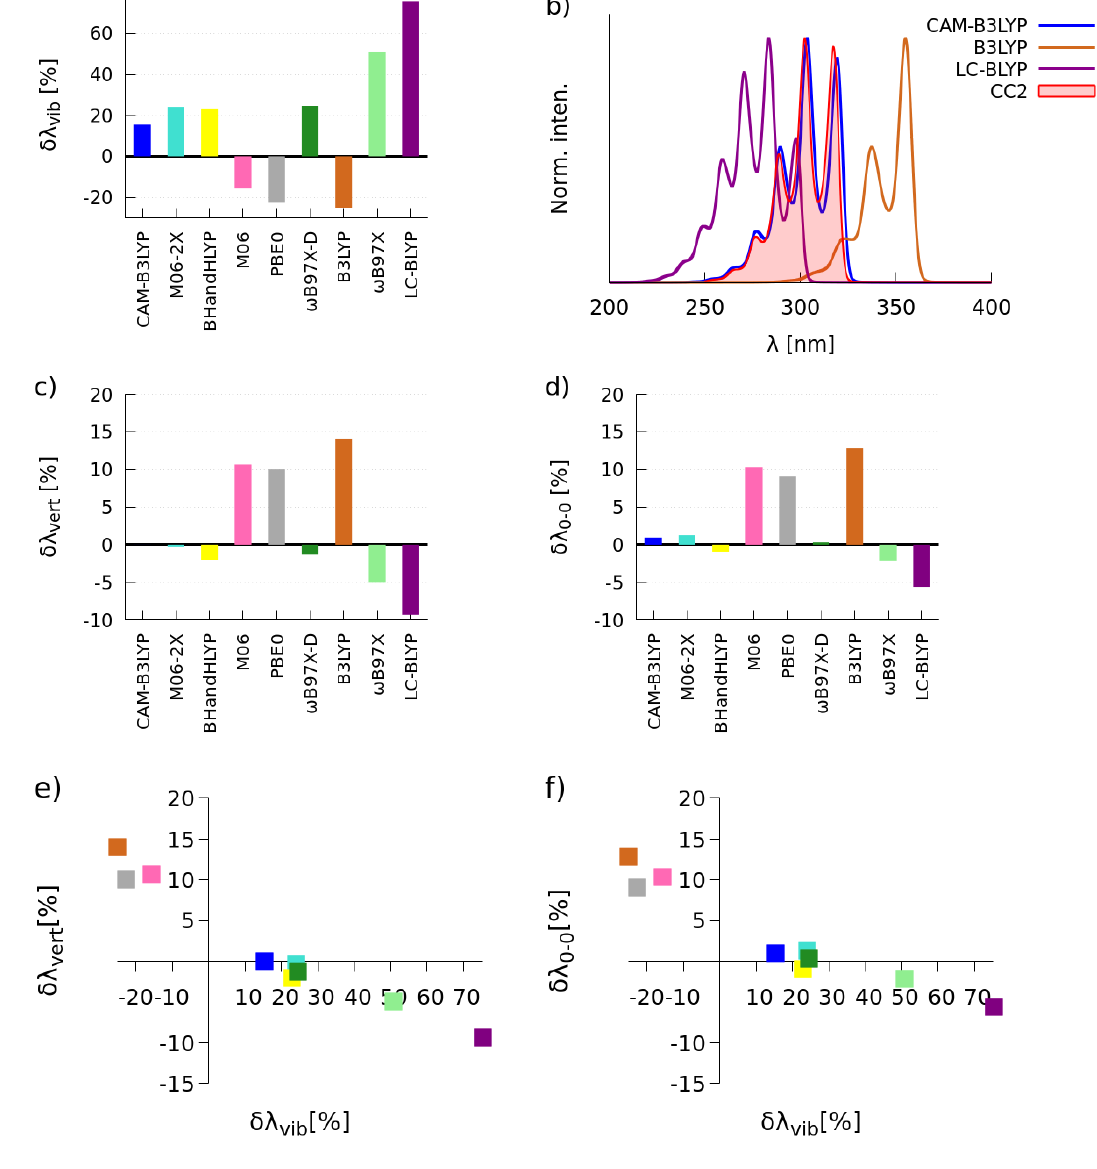
Figure 3. Bar charts showing the relative errors of λ vib ( a ), λ vert ( c ) and λ 0 − 0 ( d ) calculated with the selected XCF with respect to the CC2 reference; the selected absorption spectra, see the text for details ( b ); graphs showing the relation of relative errors, i.e., λ vert and λ vib ( e ) and λ 0 − 0 and λ vib ( f ) for the C-2